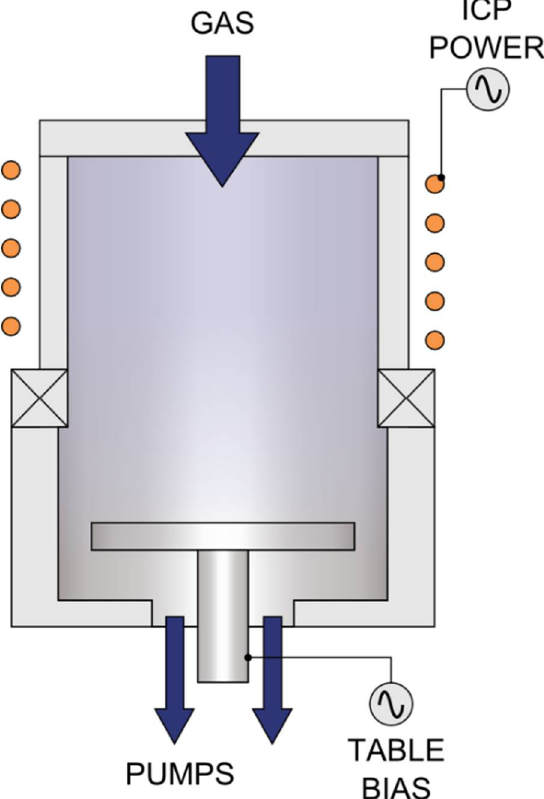
Figure 2. The scheme of the ICP-RIE reactor. Reprinted from Ref. [36].